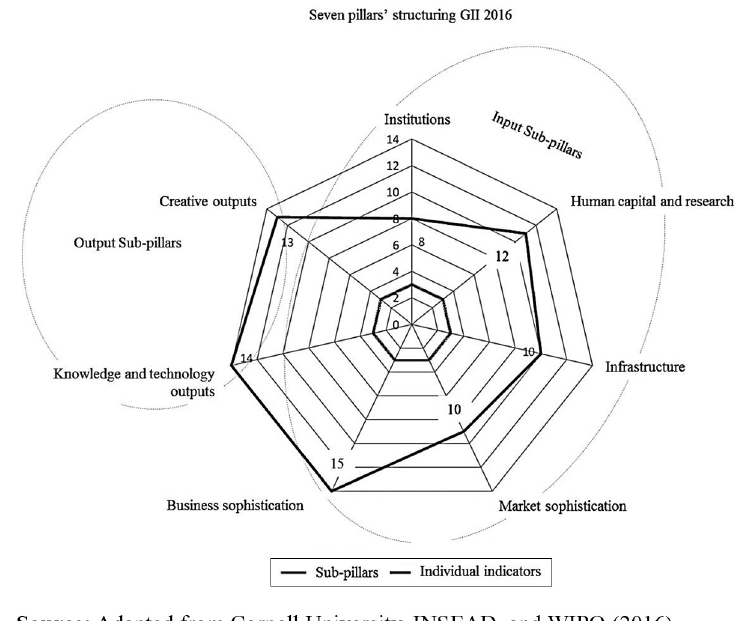
Figure 1. Seven pillars